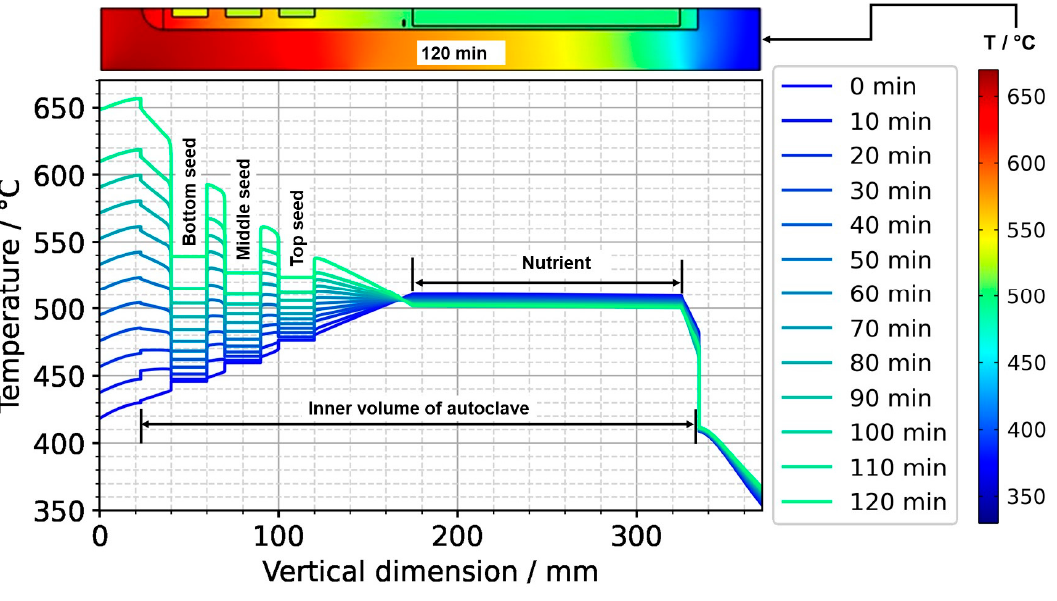
Figure 10. Temperature distribution in vertical direction in the center (0 min: quasi-stable etch-back condition, 120 min: reaching of growth stage set temperatures).